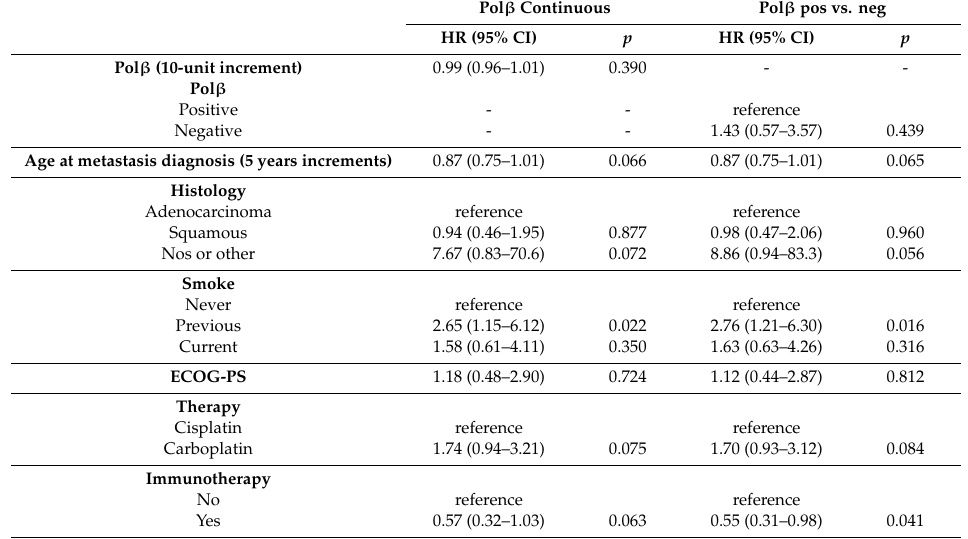
Multivariable Cox models adjusted for ECOG-PS, age, histology, smoking, therapy, and immunotherapy for OS, considering Pol β continuous and Pol β positive or negative. Pos: positive, neg: